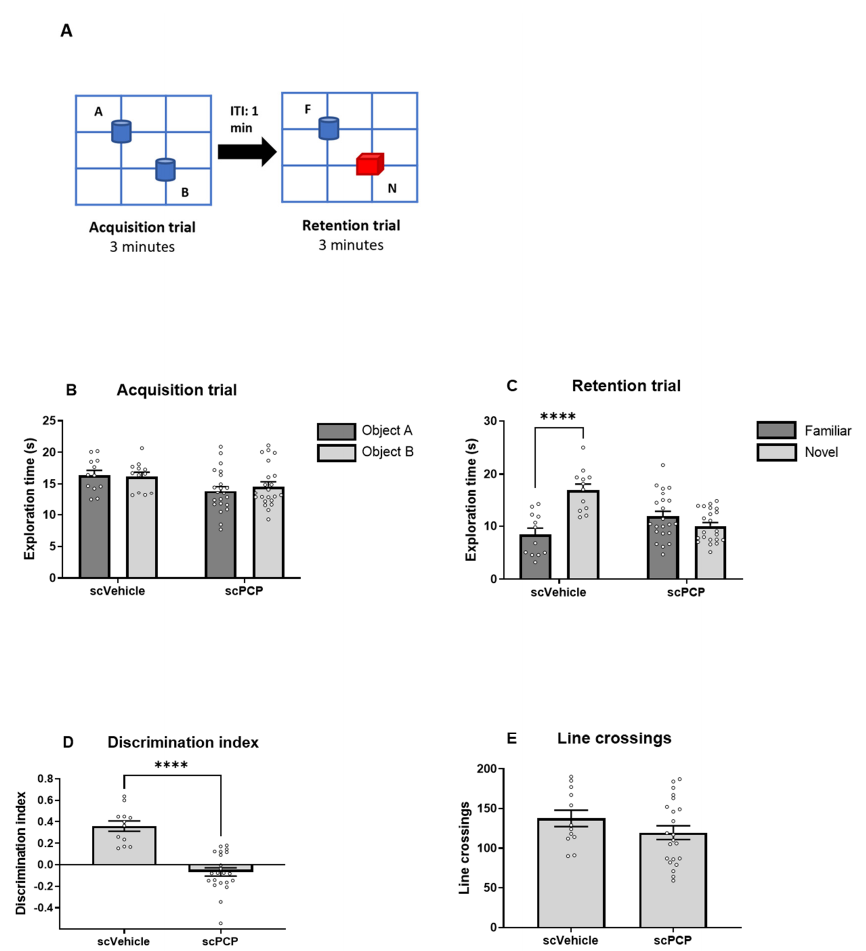
Figure 2. Verification that sub-chronic PCP (scPCP) treatment impairs novel object recognition. ( A ) Graphic depicting the novel object recognition (NOR) task protocol. A 3 min acquisition trial (with two identical objects, A and B in blue) is followed by a 1 min inter-trial interval (ITI) before a 3 min retention trial (with familiar object, F blue and novel object, N red). ( B , C ) The impact of scPCP treatment (2 mg/kg, i.p. twice daily for seven days, followed by a 6-week washout period) on the exploration time (s) of two identical objects in the acquisition phase and a familiar versus novel object in the retention phase. Data are expressed as mean ± S.E.M ( n = 12–22 per group) and were analysed using a 2-way ANOVA. **** p < 0.0001; Significant increase in exploration time of the novel relative to the familiar object. ( D ) The effect of scPCP treatment on the discrimination index (DI). Data are presented as the mean ± S.E.M ( n = 12–22 per group) and were analysed using an unpaired t -test. **** p < 0.0001; Significant reduction in DI relative to scVehicle. ( E ) The effect of scPCP treatment on total number of line crossings in the acquisition and retention trials. Data are presented as the mean ± S.E.M ( n = 12–22 per group) and were analysed using an unpaired t